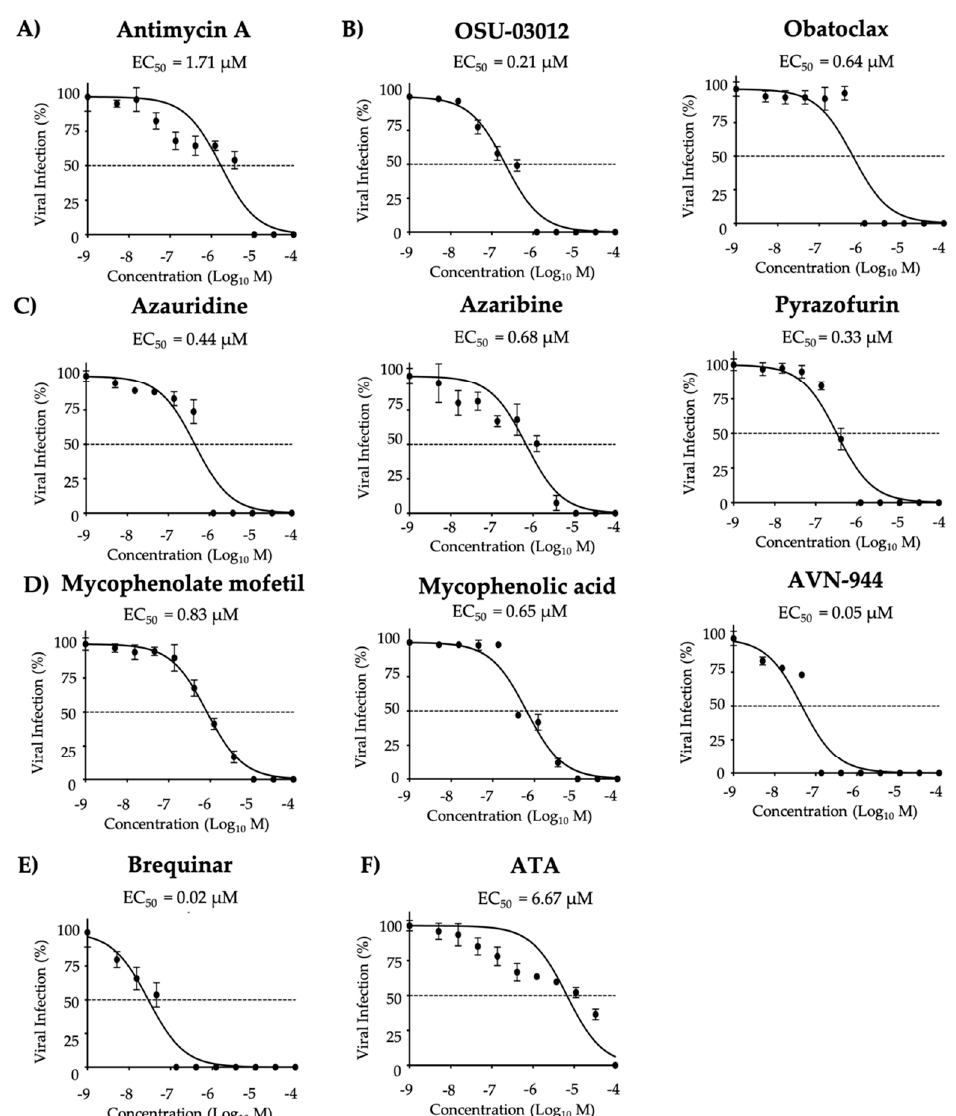
Figure 9. Inhibition of ZIKV replication in A549 cells: Human A549 cells in 96-well plate (5 × 10 4 cells/well; quadruplicates) were infected (25 PFU/well) with Paraiba/2015. After 2 h viral absorption, post-infection media (DMEM 2% FBS) containing the indicated doses of the compounds (3-folds dilutions, starting concentration 100 µM) ( A ) Antimycin A, ( B ) OSU-03012 and Obatoclax, ( C ) Azaribine, Azauridine, and Pyrazofurin, ( D ) Mycophenolate mofetil, Mycophenolic acid, and AVN-944, ( E ) Brequinar, and ( F ) Aurintricarboxylic acid (ATA) were added. At 36 h post-treatment, infected cells were fixed and immunostained with the anti-E 4G2 mAb. Plaques were counted with an automated ELISPOT reader. Dotted line indicates 50% inhibition. Data were expressed as mean and SD from three independent experiments conducted in quadruplicates.